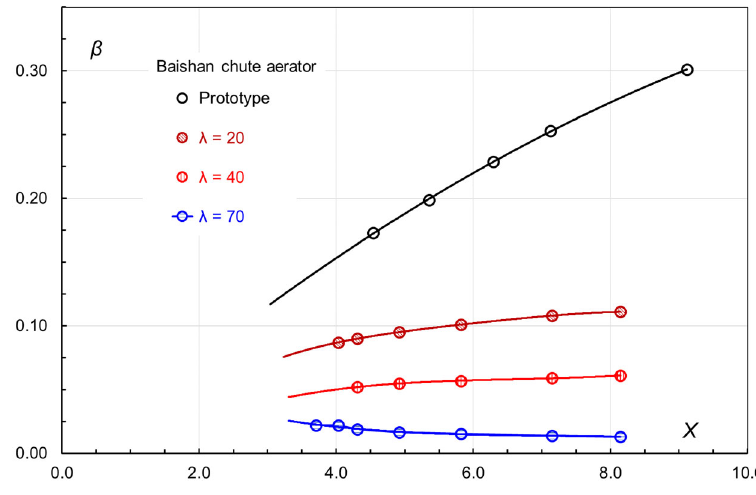
Figure 7. Baishan spillway aerator, β results from model tests of three scales ( λ = 20, 40, 70) and prototype measurements (adapted from [12]).